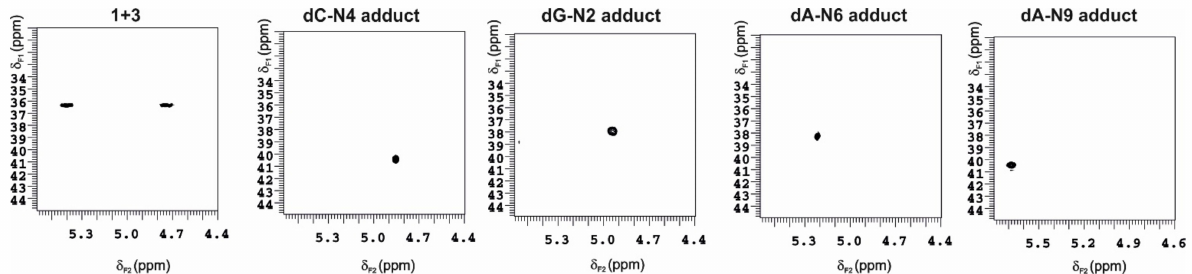
Figure 8. Partial 1 H/ 13 C HSQC spectra for biohybrid 1 + 3 of the present study and alkylated model 2 (cid:48)